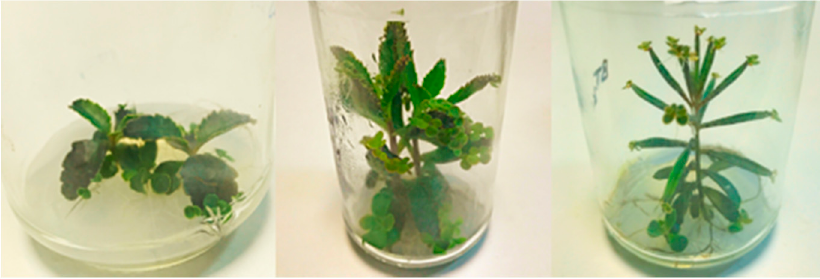
Figure 3. Foliar budding observed on donor plants of the Bryophyllum spp. BD (left) and BH (center) show foliar budding across the whole leaf margins. BT (right) shows restricted budding at the distal foliar end.